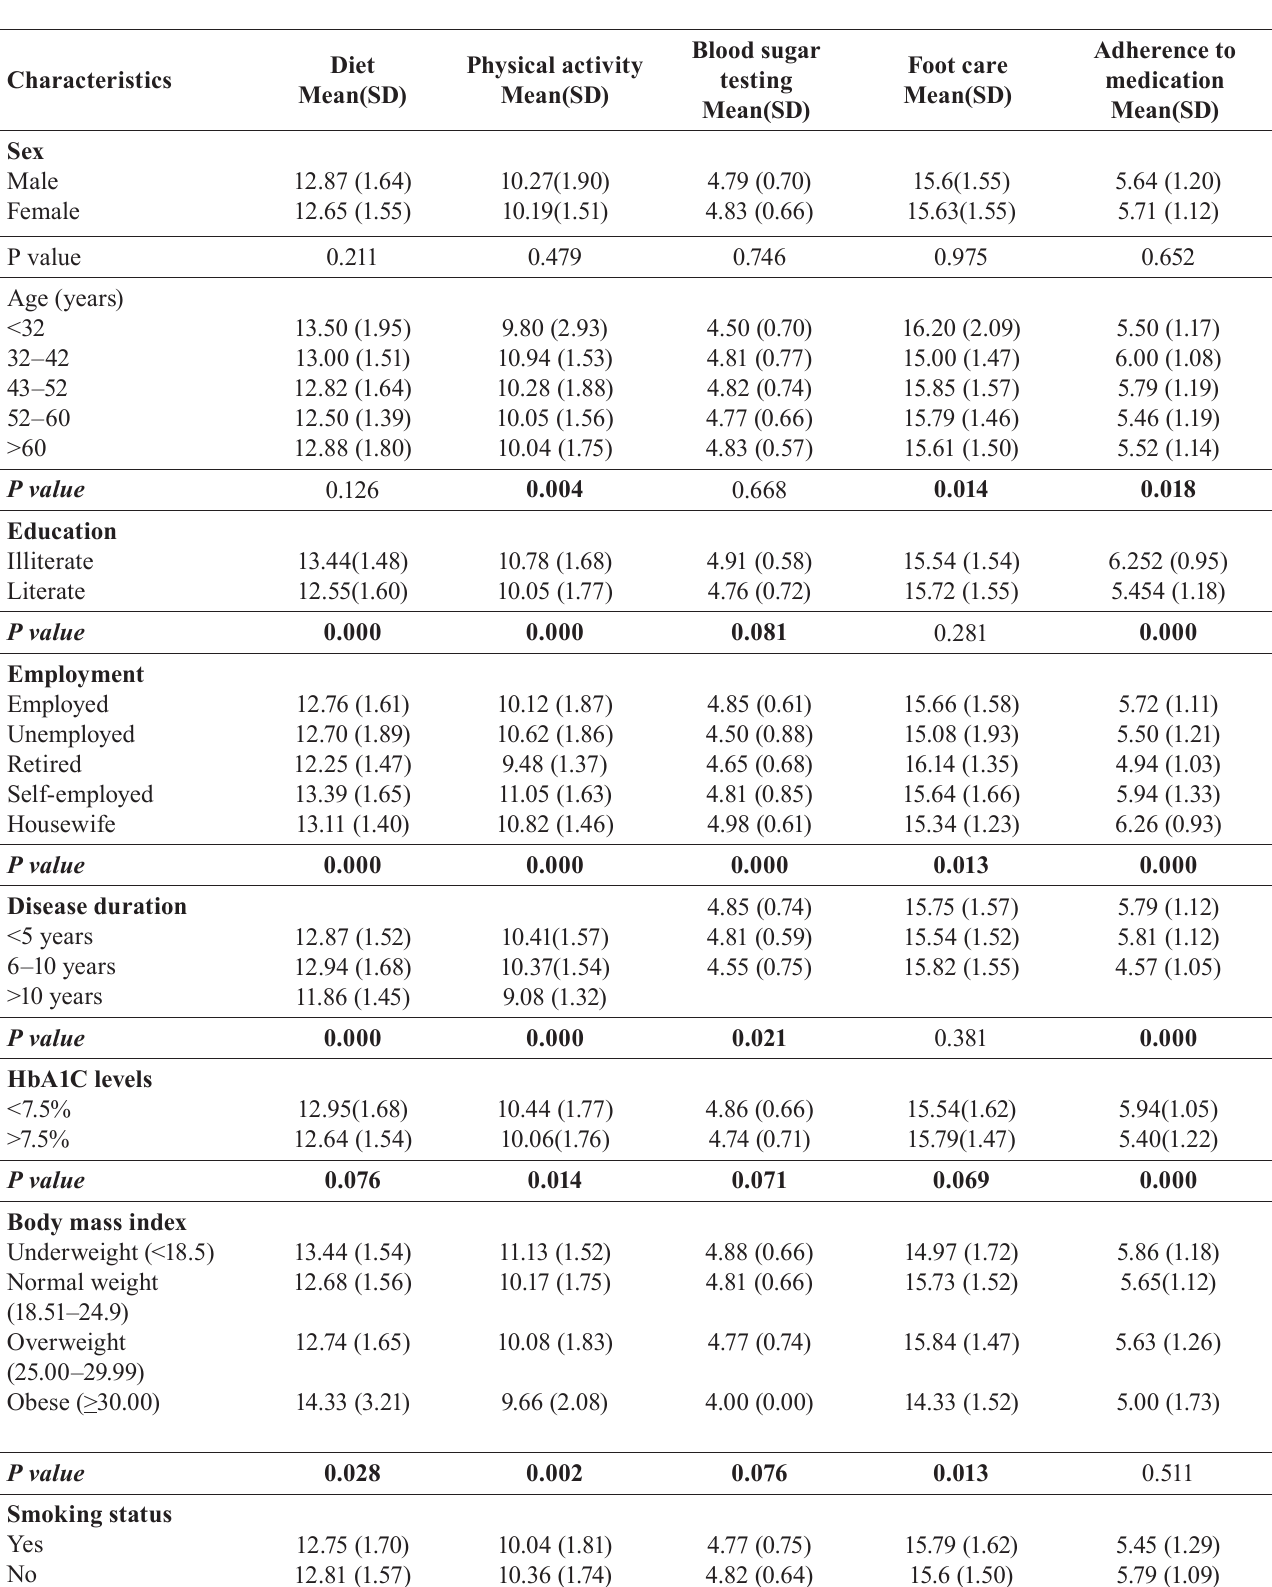
TABLE V - F actors associated with the Summary of Diabetes Self-Care Activities domains